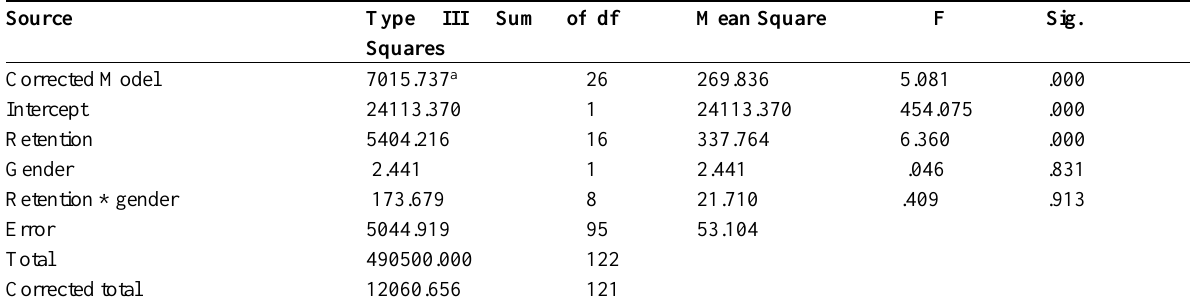
Table 2: Summary of Analysis of Covariance (ANCOVA) for test of significance of Effects of Treatment (CBL, ABL), their gender and interaction Effect with respect to their mean scores on woodwork technology cognitive retention test. Source